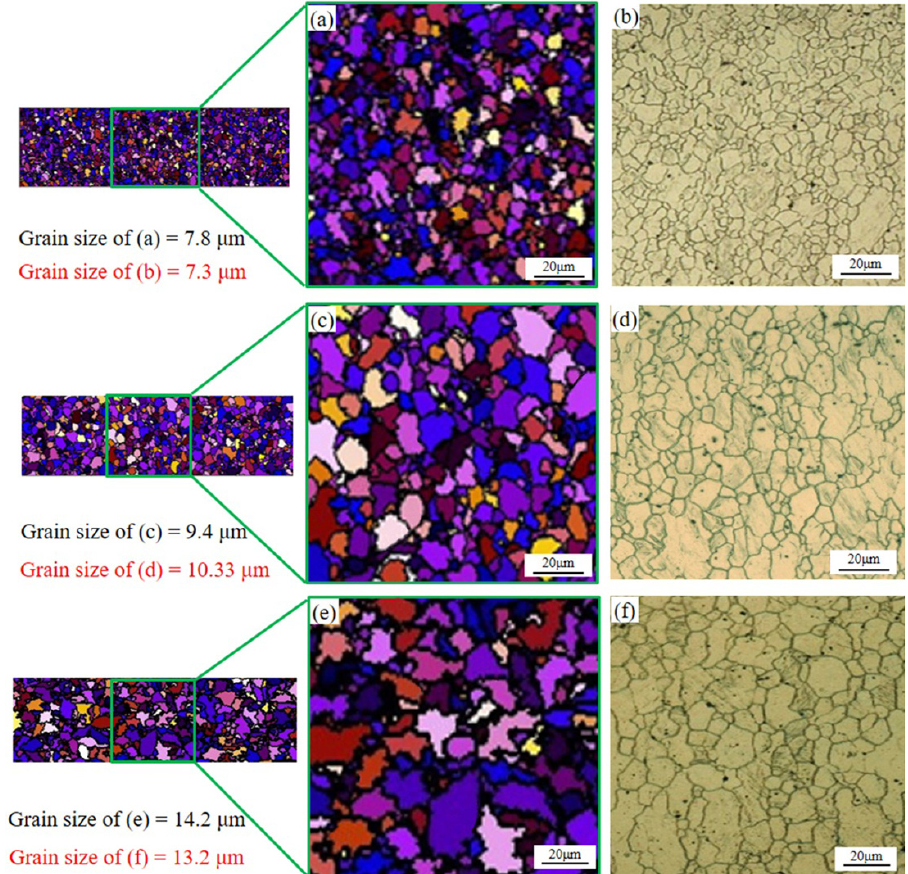
Fig. 6. Microstructures comparison between CA simulation datum and experimental results and different T ( _ e = 0.001 s (cid:1) 1 , e = 0.7): (a) and (b) T =350 ° C; (c) and (d) T =400 ° C; (e) and (f) T = 450 °